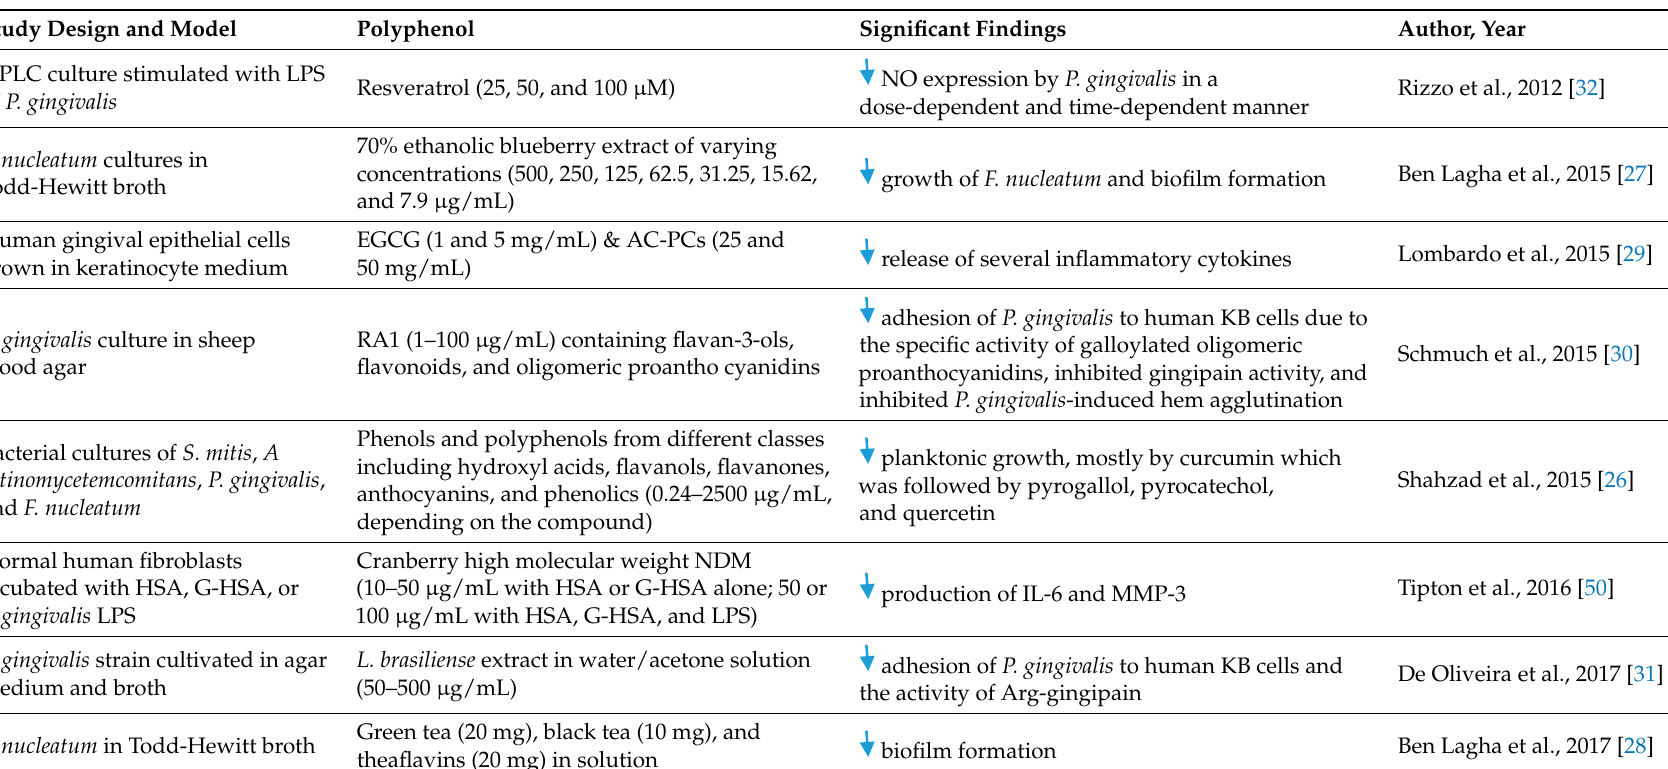
Table 1. Polyphenols as antioxidant/anti-inflammatory/antimicrobial agents in periodontitis: experimental cellular models. Table 2. Polyphenols as antioxidant/anti-inflammatory/antimicrobial agents in periodontitis: experimental animal models.